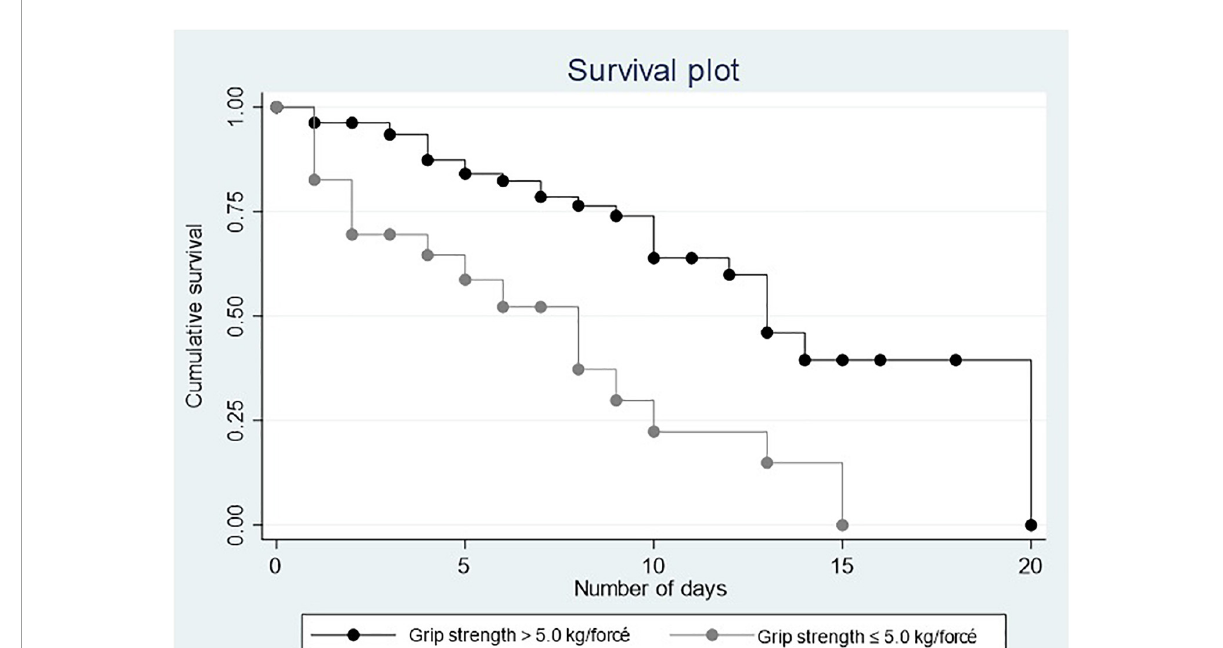
FIGURE1 Survival plots for phase angle.